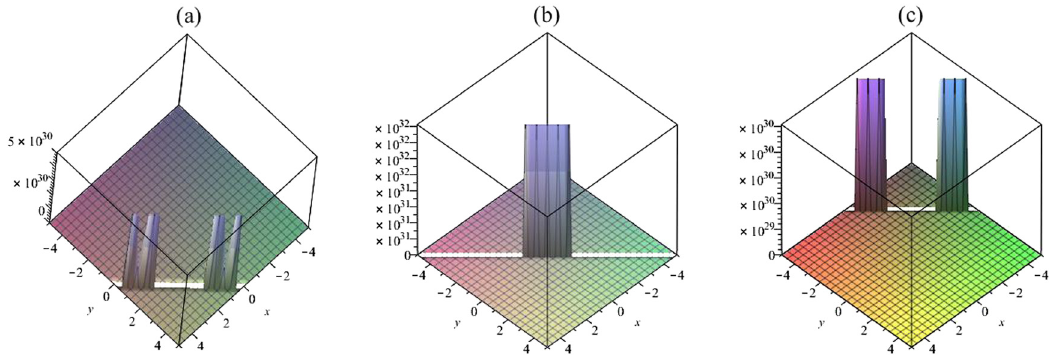
Figure 1: The propagation of solutions u r 1 with k l s 1 = = = , τ 0 = , ξ 0